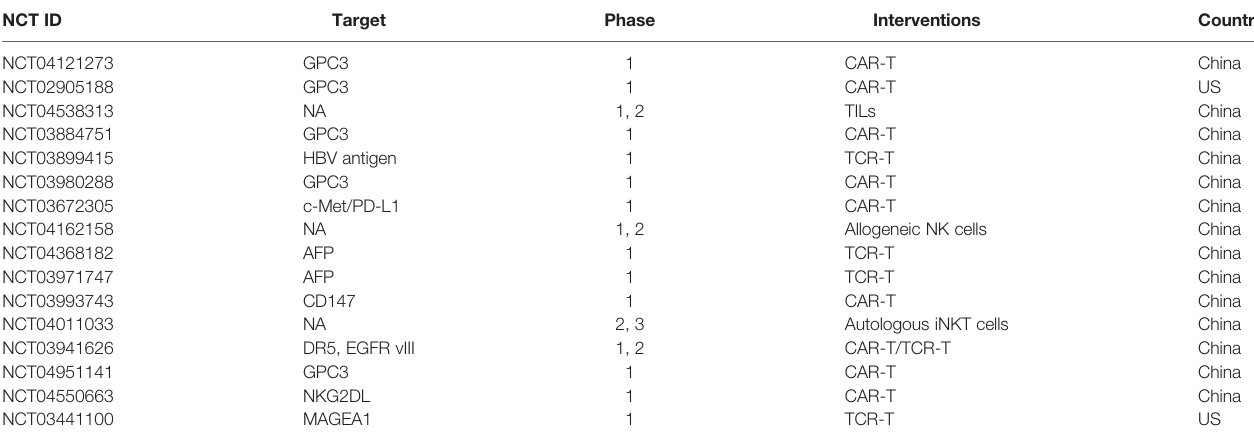
TABLE 2 | Clinical trials of ACT for HCC the last three years (www.clinicaltrails.com).